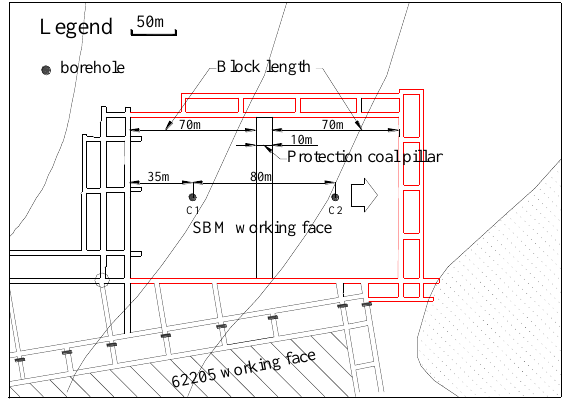
Figure 9. Arrangement of the working face in SBM.